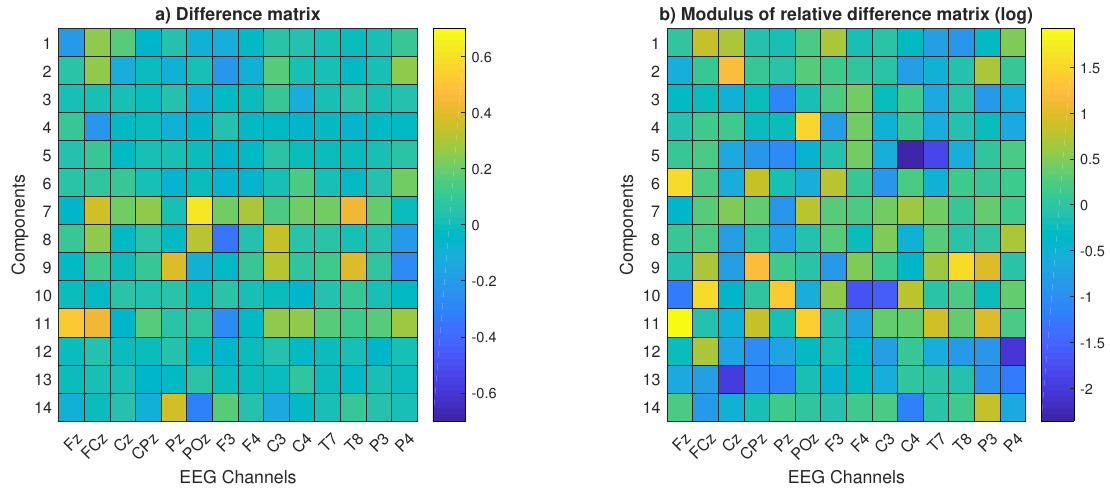
Figure 12. ( a ) Difference matrix between the original unmixing matrix given by ICA decomposition and the artifact-diminished unmixing matrix shown in Figure 11. ( b ) Relative difference matrix in logarithmic scale.